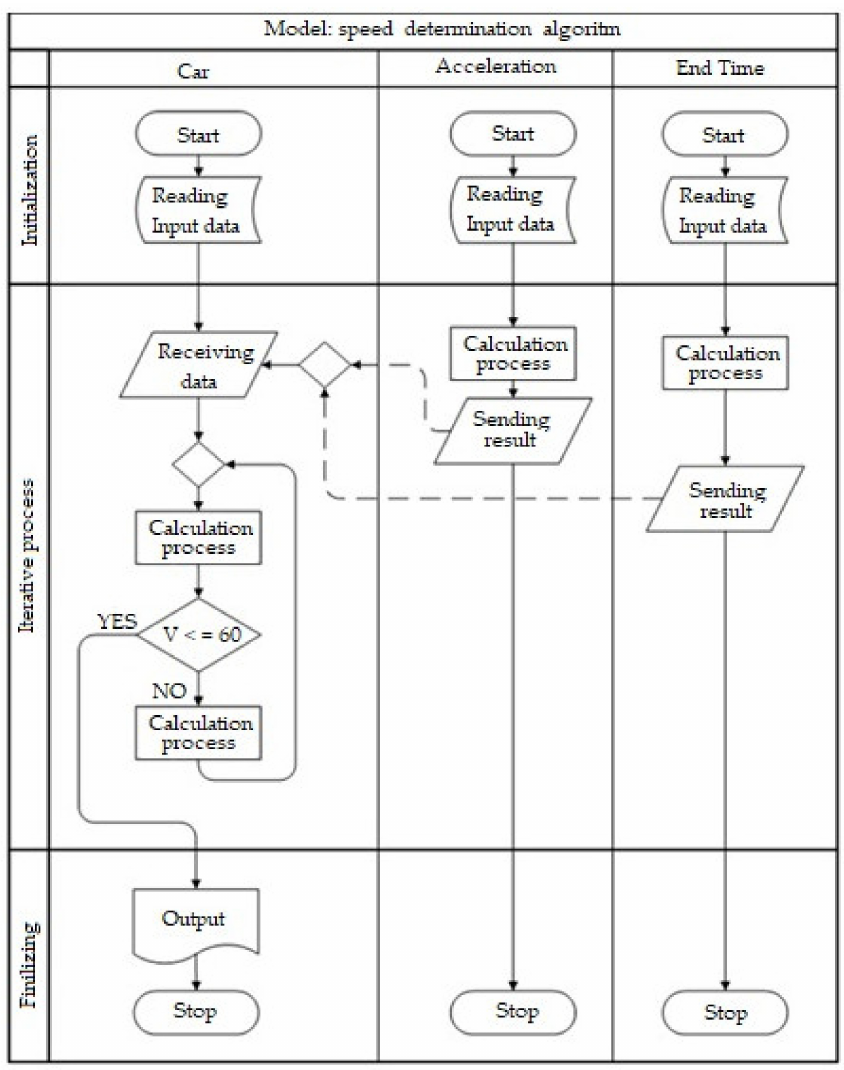
Figure 3. Operation